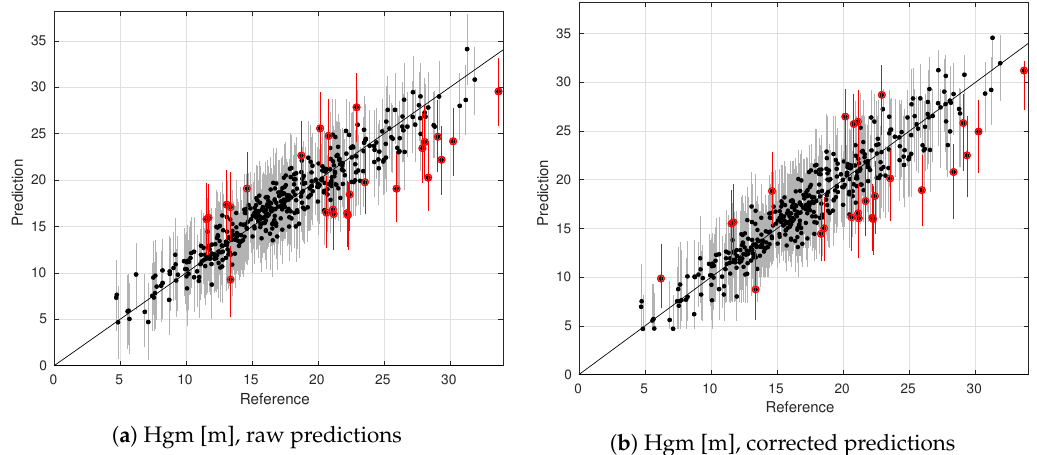
Figure 6. Transformation functions including uncertainty for Hgm and SN.